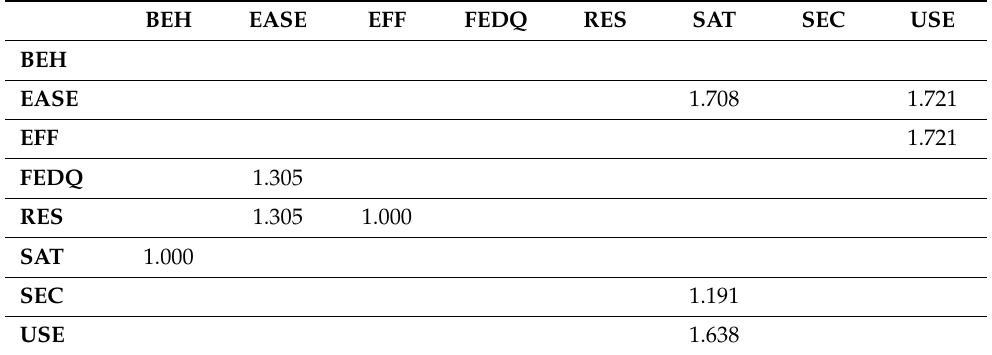
Table 5. Results of testing collinearity among exogenous constructs in the structural